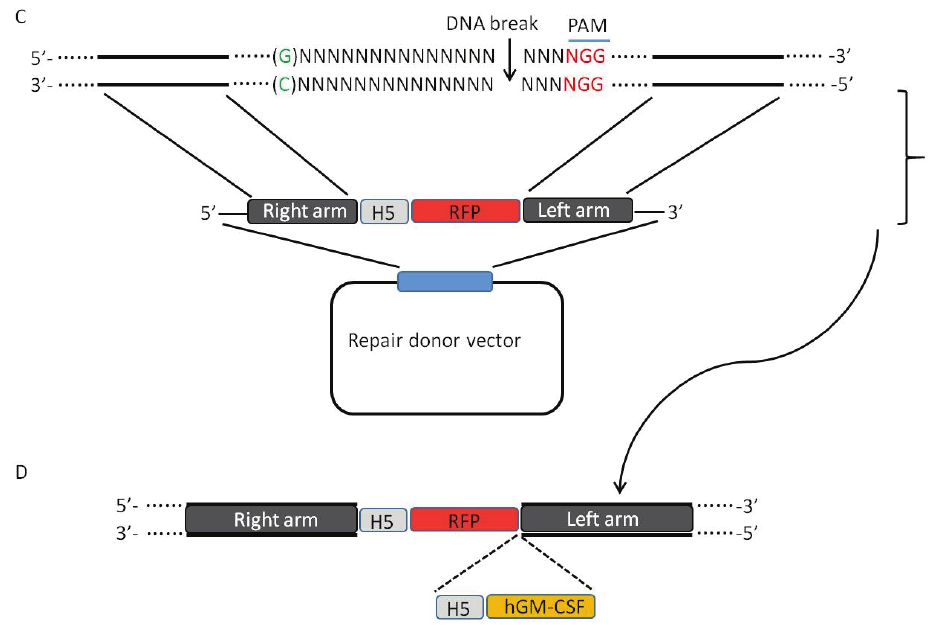
Figure 2. gRNA guided Cas9 induces homologous recombination by creating a DNA double-stranded break in the target region of vaccinia virus. ( A ) The gRNA is transcribed; ( B ) gRNA guides Cas9 to the target site; ( C ) Cas9 creates a DNA double-stranded break, which is repaired by the repair donor vector via the mechanism of homologous recombination; and ( D ) the mutant vaccinia virus is generated with the deletion of the target gene and insertion of the purification marker RFP containing its promoter H5. A therapeutic gene hGM-CSF and its promoter H5 can also be incorporated into the target gene.